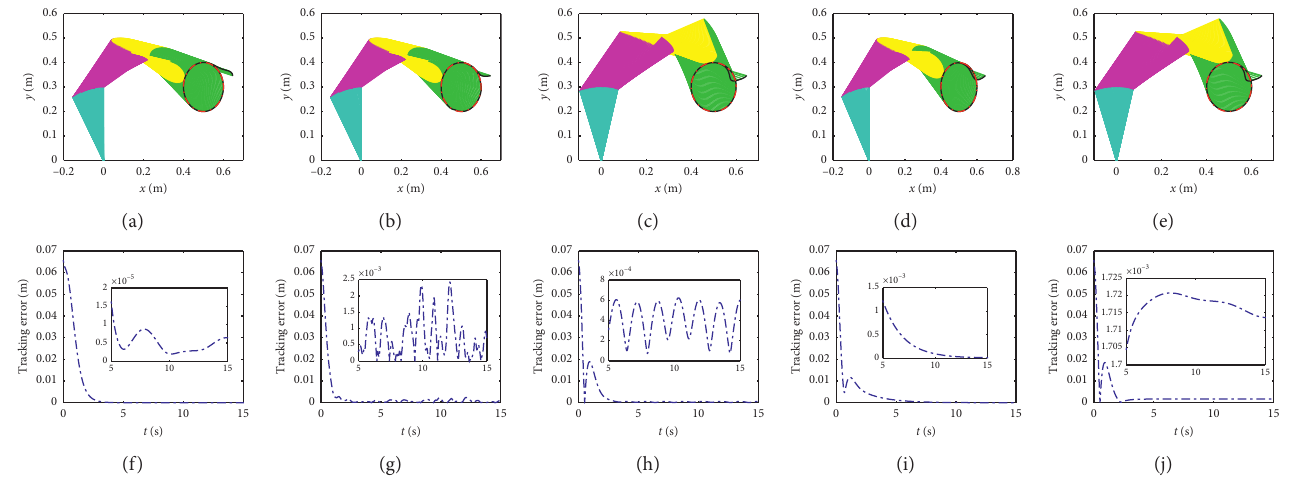
Figure 6: Circle trajectory tracking results and tracking errors achieved by equation (10) disturbed by the external disturbances. (a) Constant-valued noise ω � 1. (b) Random noise ω ∈ 0 , 1 { } . (c) Sine-form noise ω � [ 0 . 01 sin ( 2 t ) , 0 . 01cos ( 0 . 5 t )] T . (d)